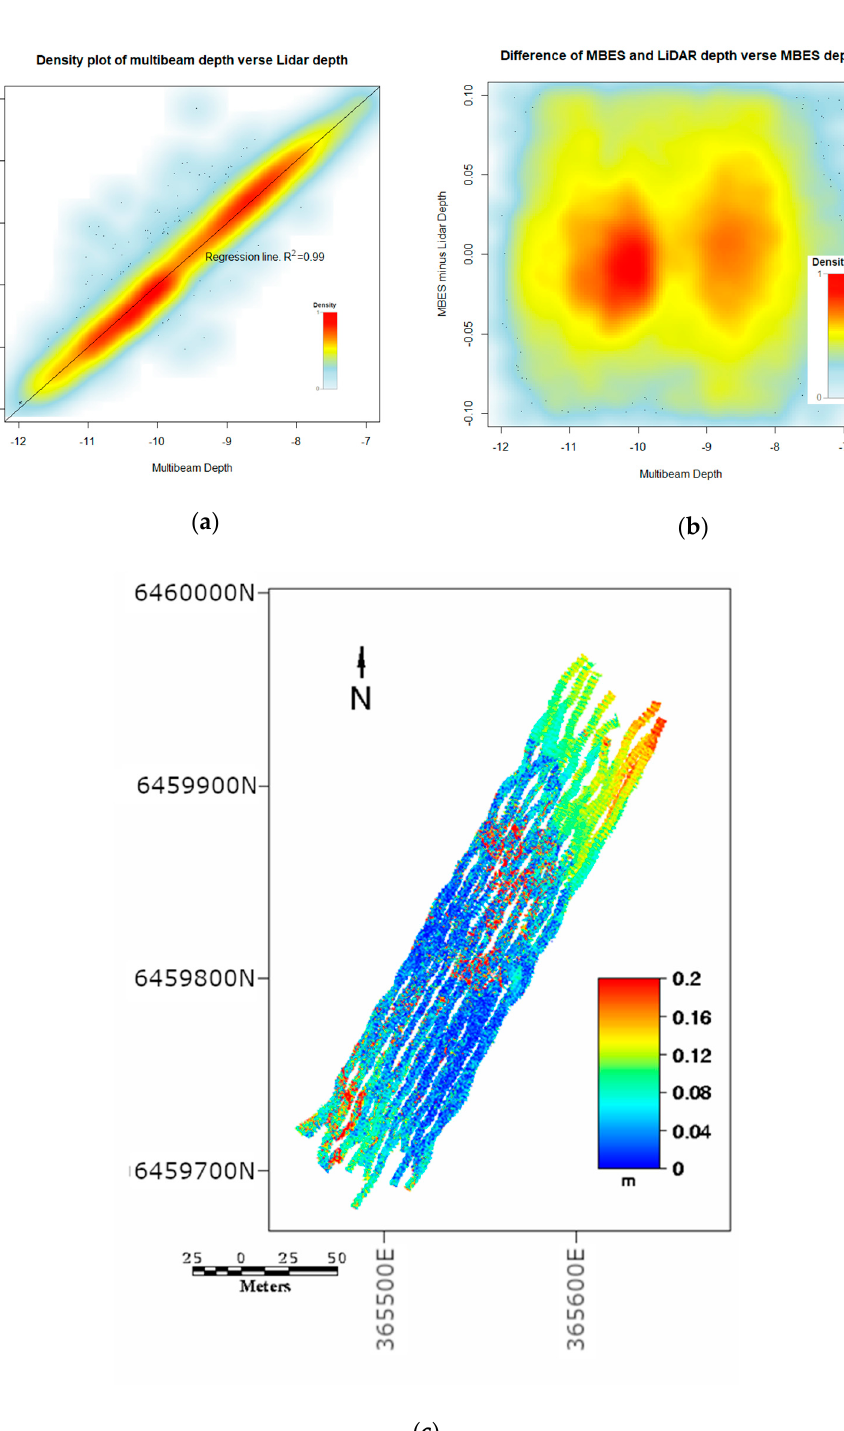
Figure 7. ( a ) Plot of MBES depths verses LiDAR depths. ( b ) Di ff erence between LiDAR depths and MBES depths. ( c ) Absolute di ff erence in depth between MBES depths and LiDAR depths